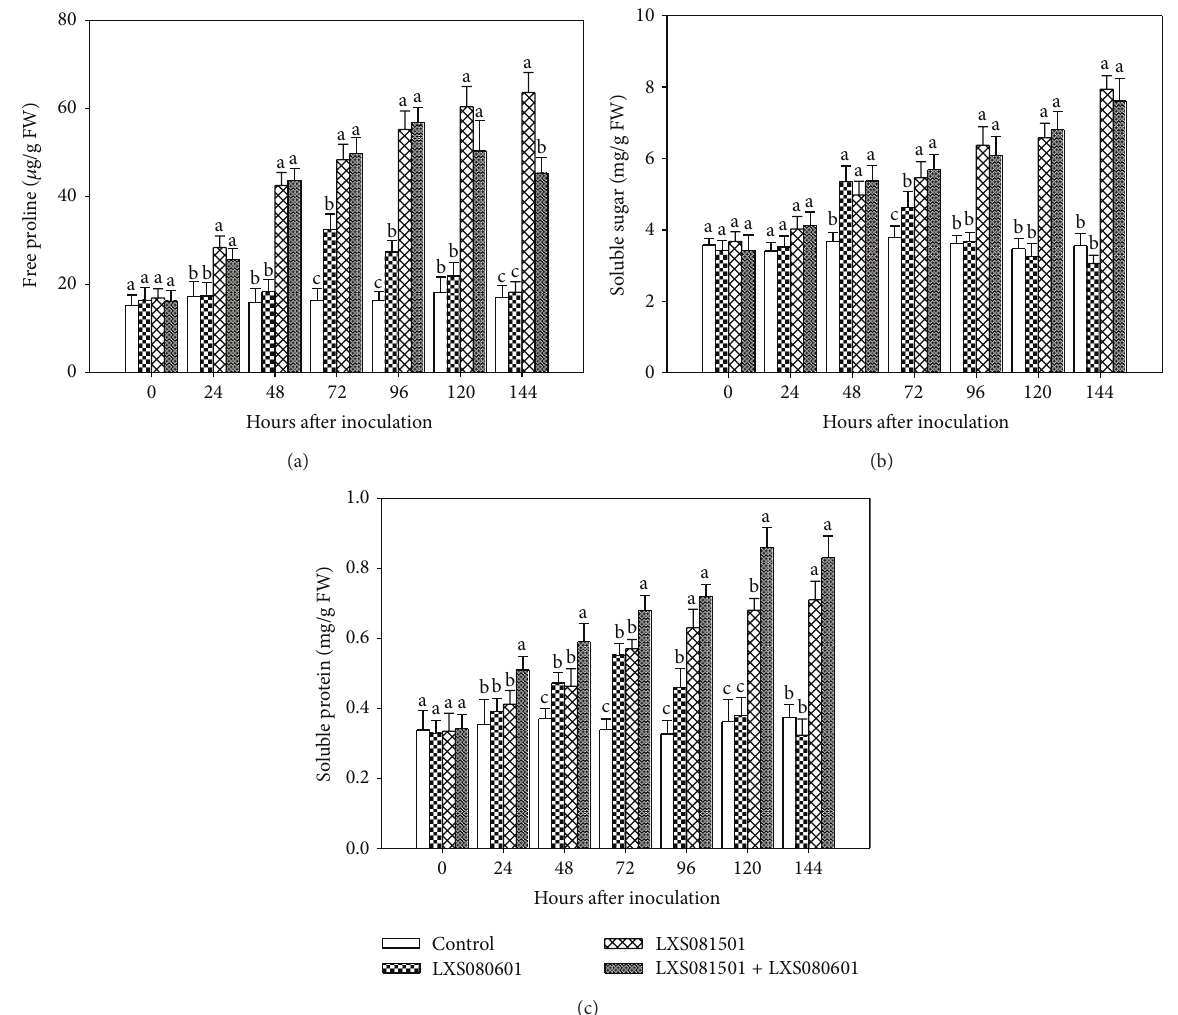
Figure 2: Changes in free proline content ( 𝜇 g/gFW), soluble sugar, and soluble protein contents (mg/gFW) in the apple calli inoculated with PDA (control), LXS080601, LXS081501, and LXS081501 + LXS080601. Data represent the mean of “Fuji” and “Gala” cultivars in two independent experiments. Error bars represent standard error of the mean. Different letters on the bar show statistical significance ( 𝑃 < 0.05 ) in the osmotic adjustment substance contents at the indicated time